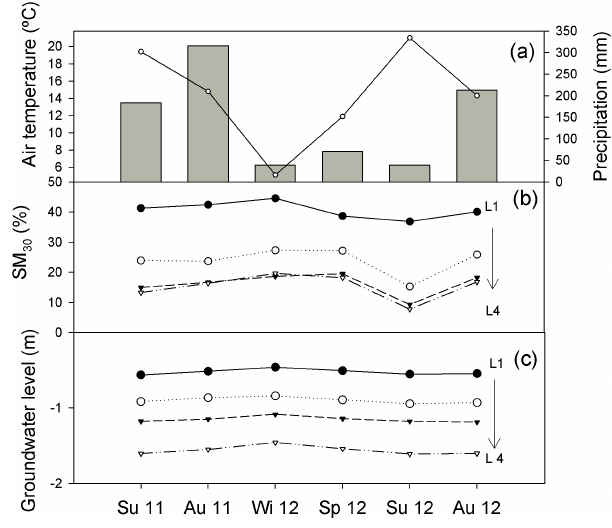
Figure 2. Seasonal changes of summer 2011 (Su 11), autumn 2011 (Au 11), winter 2012 (Wi 12), spring 2012 (Sp 12) summer 2012 (Su 12) and autumn 2012 (Au12) in (a) mean seasonal air tempera- ture and precipitation; (b) 30cm integral soil moisture (SM 30 ); (c) groundwater level, value represents the depth of groundwater level from soil surface (L1, L2, L3 and